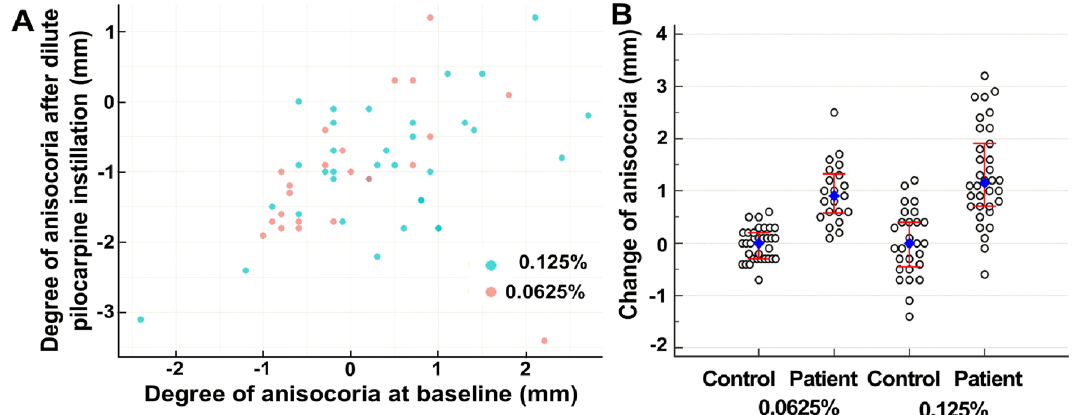
Figure 1. ( A ) Scatter plots of the amount of anisocoria after dilute pilocarpine instillation in patients with unilateral tonic pupil with respect to anisocoria at baseline in both pilocarpine dosage groups. There were no significant differences of ansiocoria in darkness both at baseline ( P = 0.157) and after pilocarpine instillation ( P = 0.901) between the two groups. ( B ) Dot plots of the change in anisocoria from baseline to post- pilocarpine test for each patient and control in both pilocarpine dosage groups. The change in anisocoria from baseline to post-pilocarpine test in the patients with unilateral tonic pupil were 1.30 ± 0.92 mm in the 0.125% group and 0.90 ± 0.64 mm in the 0.0625% group showing no significant difference between the two pilocarpine dosage groups ( P = 0.08). In both pilocarpine dosage groups, comparison of patients with the respective controls revealed significant differences in the amount of change in anisocoria (both P < 0.01). The red error bars show 25% and 75% percentiles of the change in anisocoria from baseline to post-pilocarpine test for each patient and control in both pilocarpine dosage groups.